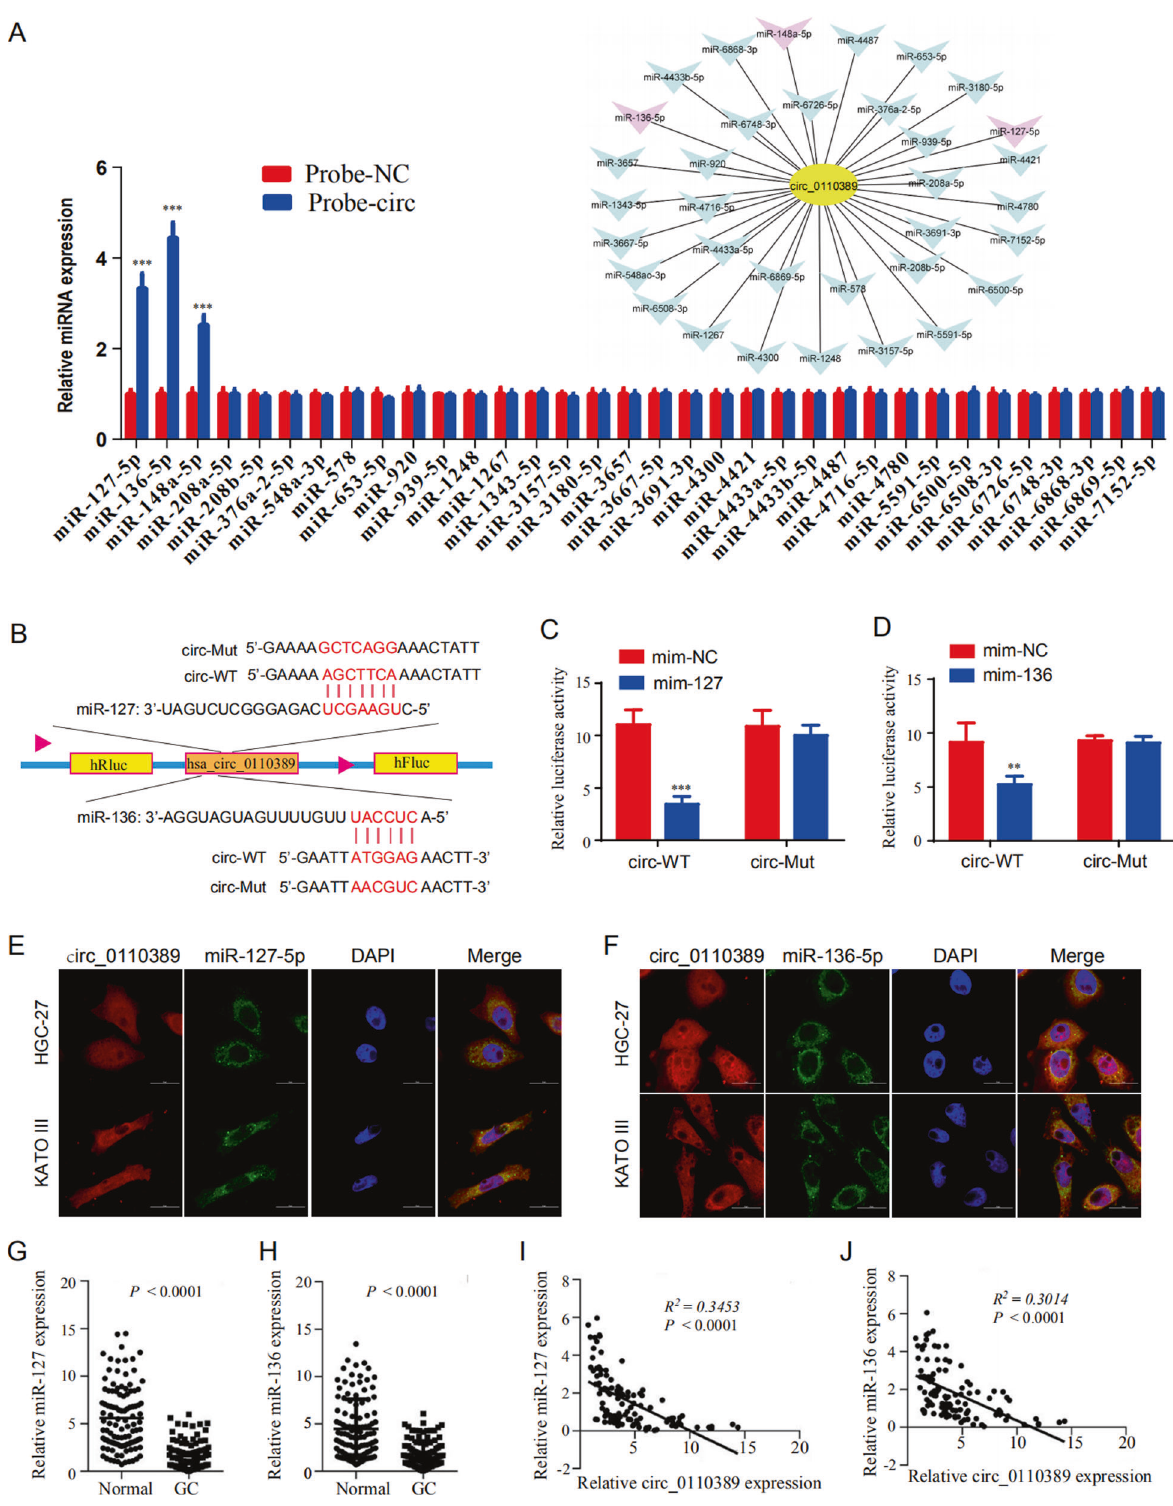
Fig. 3 Hsa_circ_0110389 acts as a molecular sponge for miR-127-5p and miR-136-5p. A Bioinformatics analysis showed potential binding interaction between hsa_circ_0110389 and different miRNAs, and RNA pull-down results showed that hsa_circ_0110389 may directly bind with miR-127-5p, miR-136-5p and miR-148a-5p. B Schematic illustration of the sequences of wild type hsa_circ_0110389 (circ-WT) and mutant hsa_circ_0110389 (circ-Mut) in the binding sites of miR-127-5p and miR-136-5p. C , D Relative luciferase activities were detected in GC cells after transfecting luciferase reporter plasmids with wild type or mutant of hsa_circ_0110389 with miR-127-5p/miR-136-5p or negative control. mim, mimic. E , F FISH for subcellular localization of hsa_circ_0110389 and miR-127-5p or miR-136-5p in HGC-27 and KATO III cells. G , H Expression of miR-127-5p ( G ) or miR-136-5p ( H ) in 110 paired GC tissues and adjacent normal tissues. I , J Correlation between miR-127-5p ( I ) or miR-136-5p ( J ) and hsa_circ_0110389 expression in 110 paired GC tissues. The correlation was measured by Pearson correlation analysis. All data are presented as mean ± SD. ** P < 0.01, *** P < 0.001. Cell Death and Disease (2021)